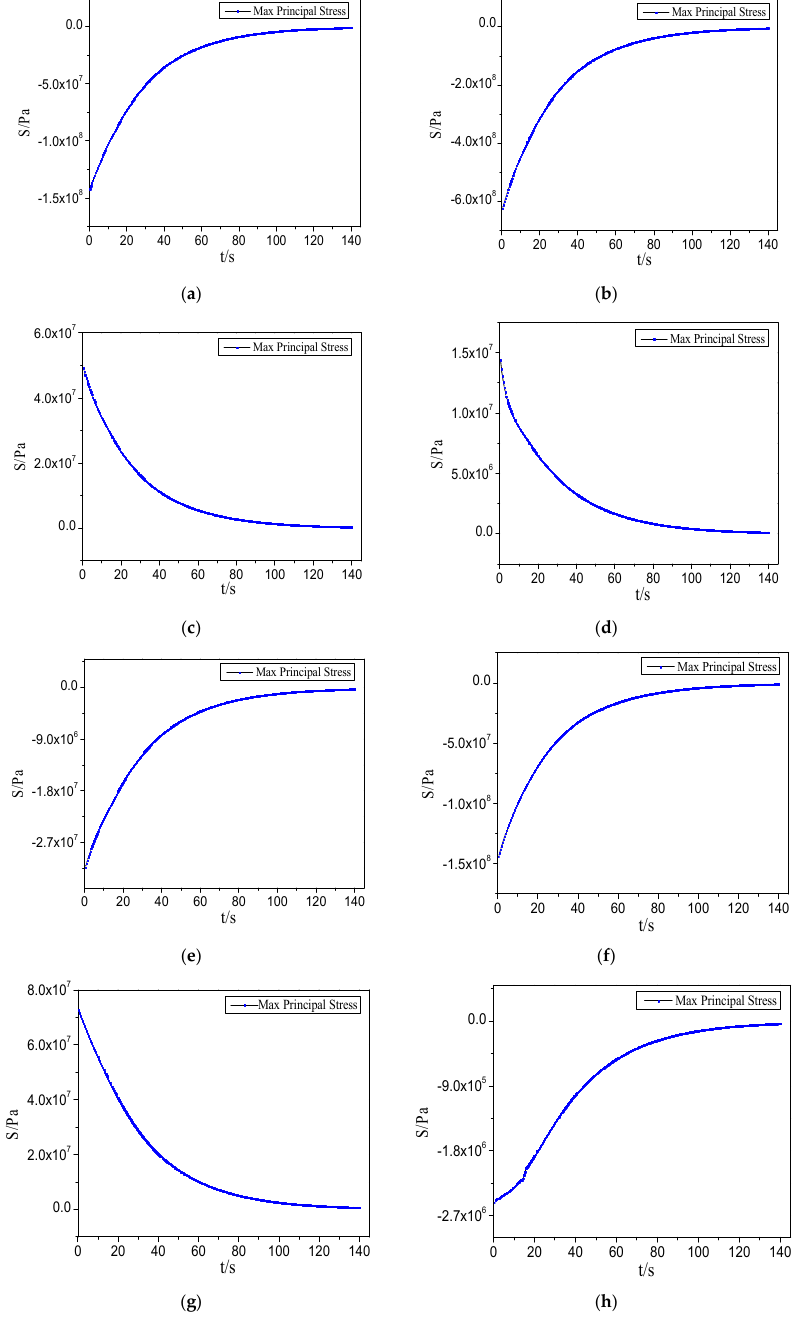
Figure 19. The stress curves of the elements near the crack tip in the cooling process. ( a ) The stress curve of element one ( b ) The stress curve of element two; ( c ) The stress curve of element three; ( d ) The stress curve of element four; ( e ) The stress curve of element five; ( f ) The stress curve of element six; ( g ) The stress curve of element seven; ( h ) The stress curve of element